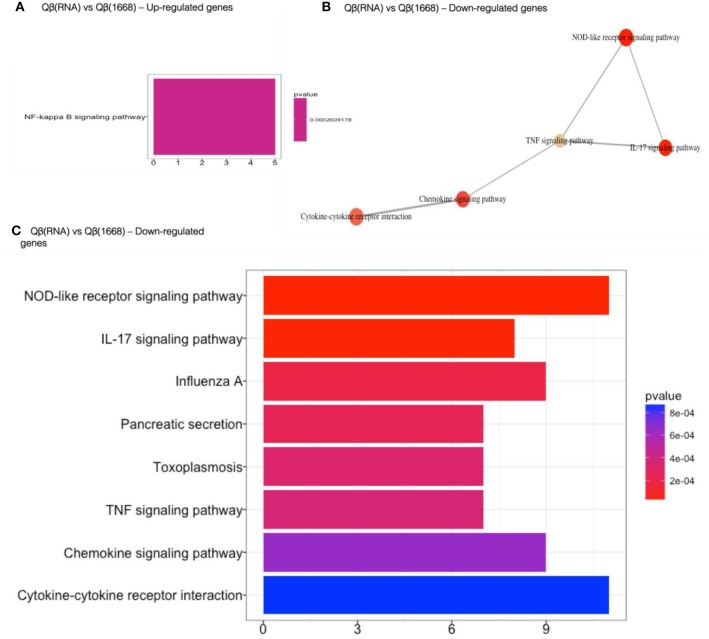
Gene set enrichment analysis of differently regulated genes on Qβ(RNA) vs Qβ(1668). (A) Gene set enrichment analysis of up-regulated genes). (B) Gene set enrichment analysis of down-regulated genes. Pathways sharing gene sets are connected by a line. (C) Gene set enrichment analysis of down-regulated genes. Significance displayed as a color scale as indicated by the p-value. X-axis: number of genes in the dataset per pathway.